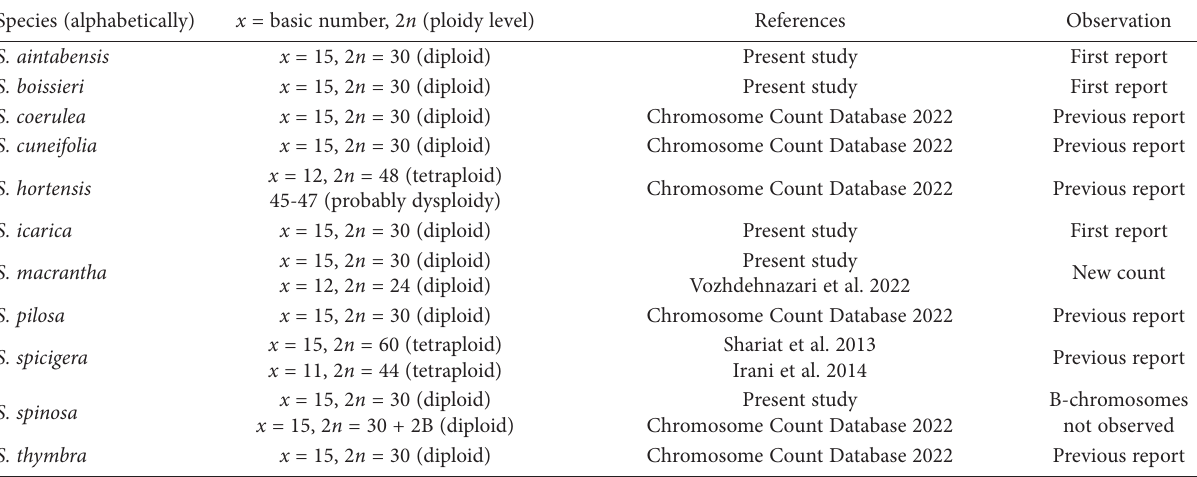
Table 3. The chromosome numbers of Turkish Satureja in present and previous studies. Species